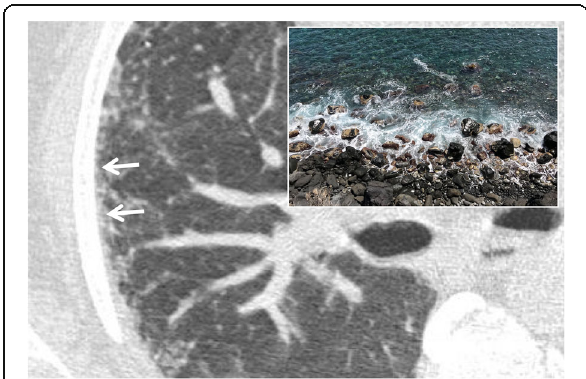
Fig. 21 Interface sign. Irregular appearance of pleural surface due to fibrosis (white arrows) in a case of UIP. In cases of interstitial disease with fibrous component, interstitial thickening with focal retractions of the pulmonary parenchyma may develop — creating an alteration of the regularity of the profiles between lung parenchyma, vessels, bronchi, or visceral pleura. In these cases, it is possible to observe a “ jagged appearance